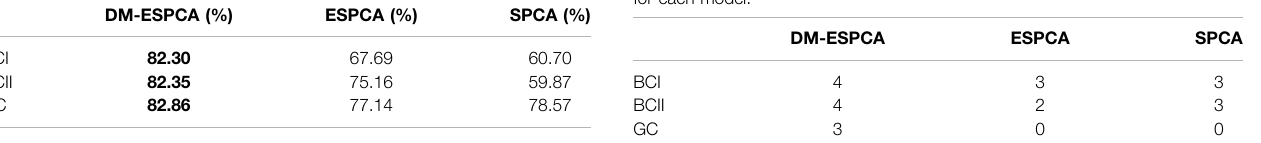
TABLE 2 | Clustering results obtained by the three sparse PCA methods. TABLE 3 | Number of PCs that can fi nd gene probes related to the target cancer for each